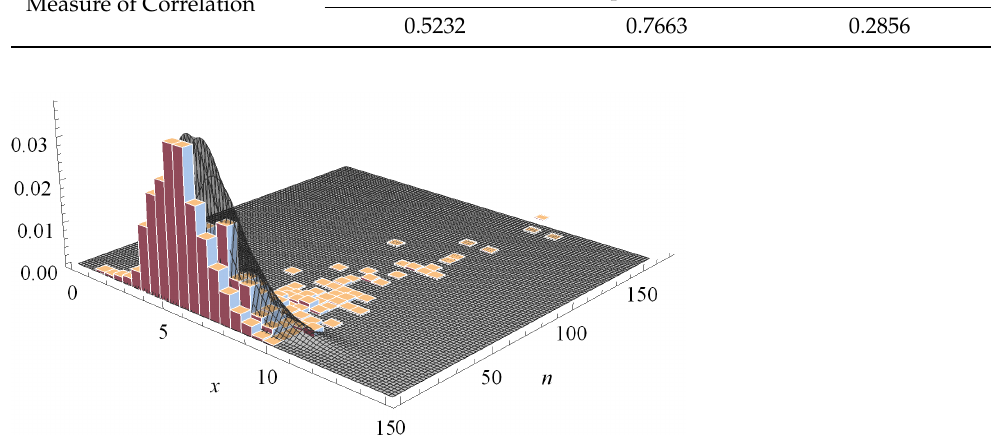
Figure 2. Empirical (smoothed) distribution (histogram) and theoretical distribution model of the bivariate distribution